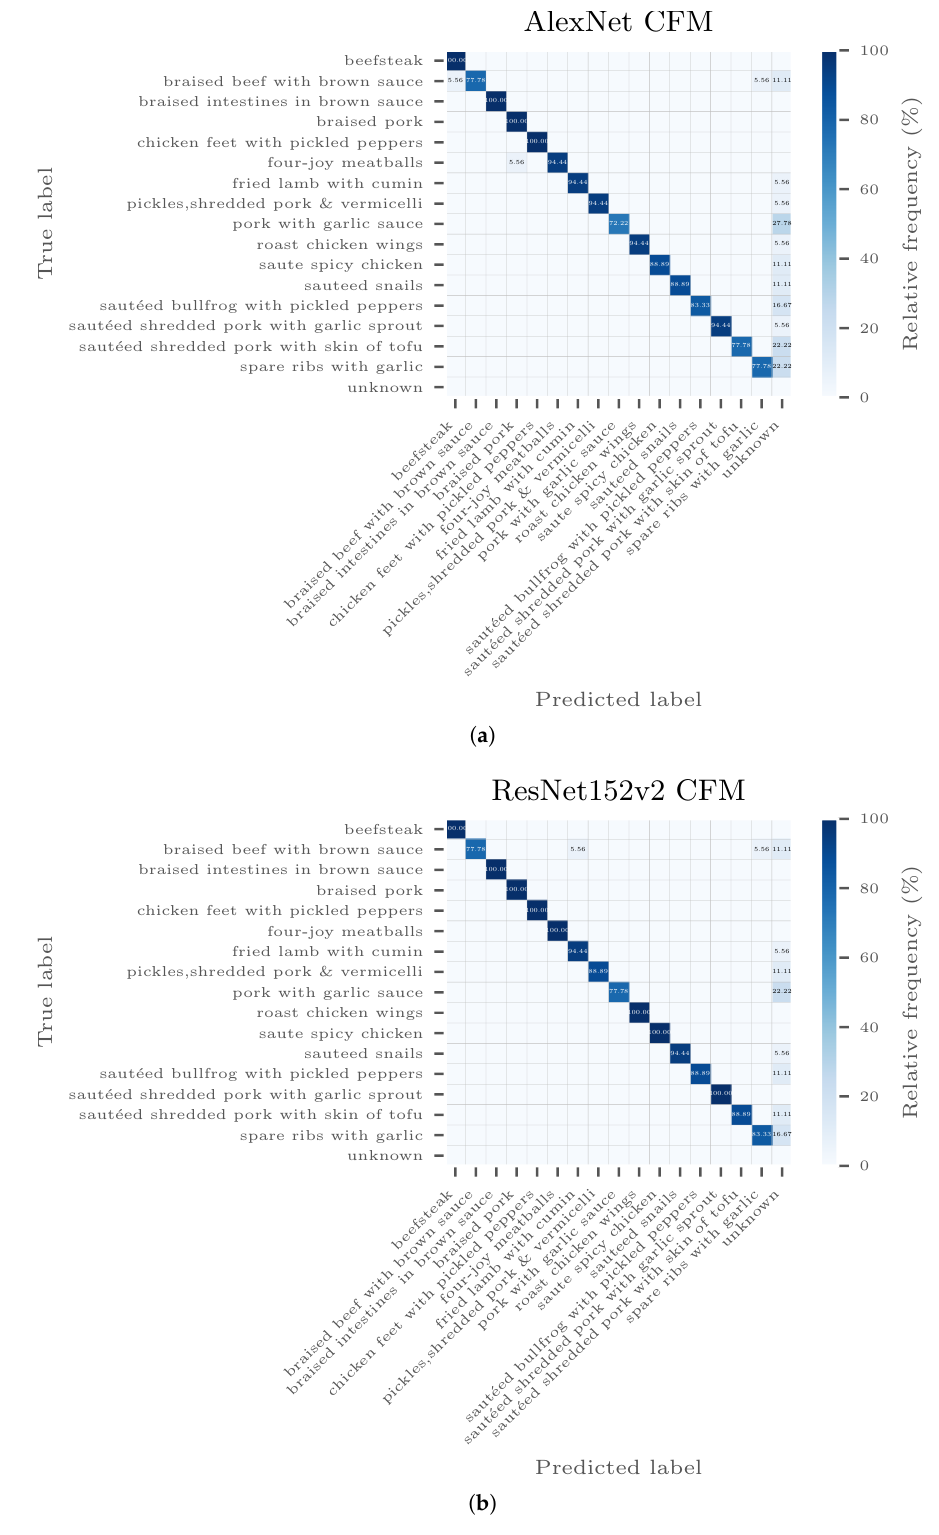
Figure A6. AlexNet ( a ) and ResNet ( b ) confusion matrices in VireoFood-172